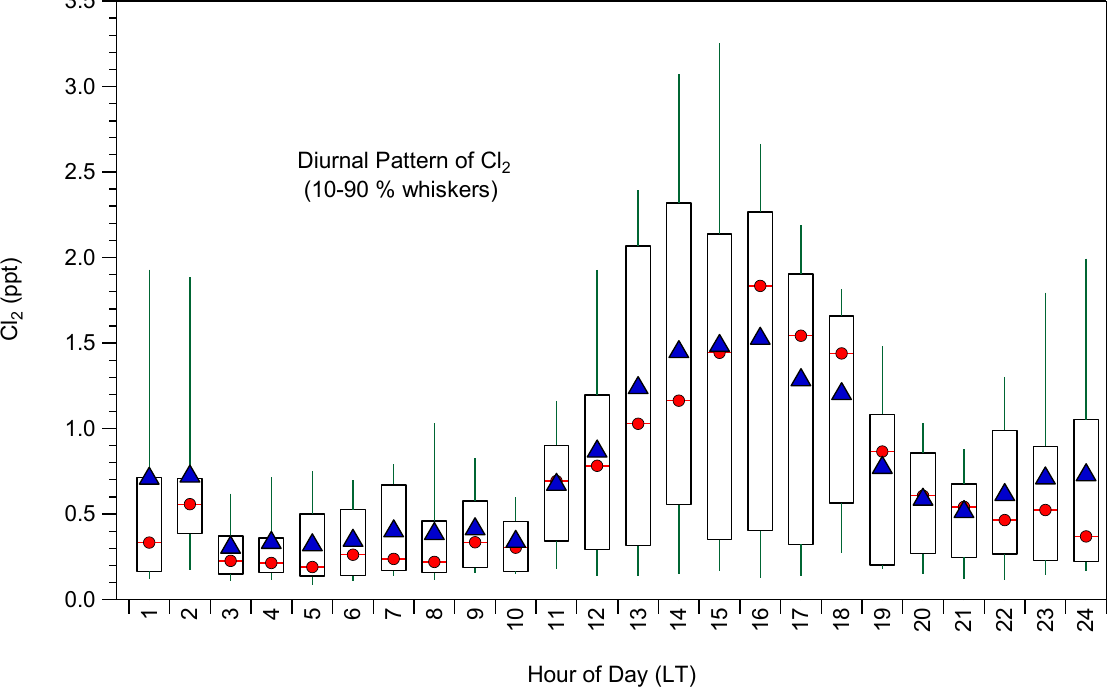
Figure 3. Diurnal pattern of Cl 2 concentrations observed from 11–21